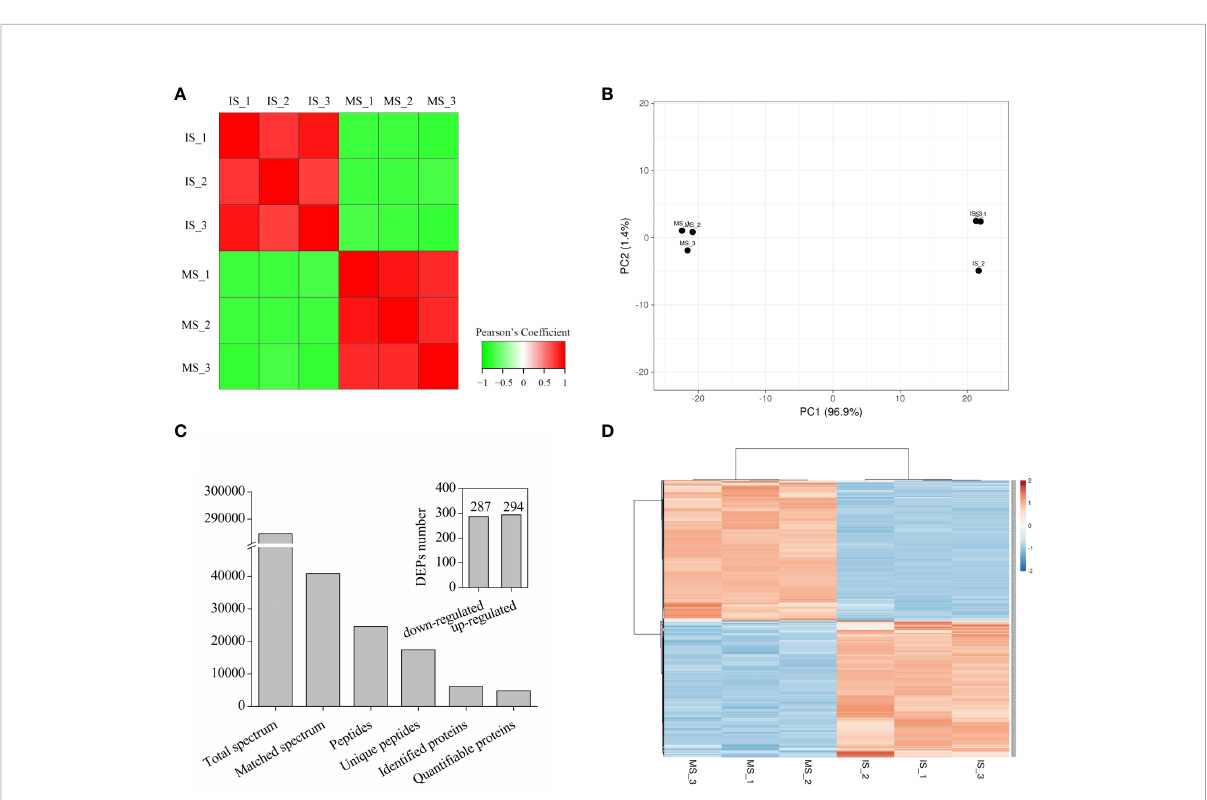
FIGURE 2 Summary of tandem mass tag proteomics analysis in quinoa seed from different developmental stages. (A) Pearson ’ s correlation coef fi cient was calculated from three biological replicates for each biotype/treatment. (B) Principal component analysis of quinoa seed in different stages. (C) Summary of the MS/MS spectrum and identi fi ed differentially accumulated proteins (DAPs). (D) Hierarchical clustering analysis of all DAPs in quinoa seed from different developmental stages.